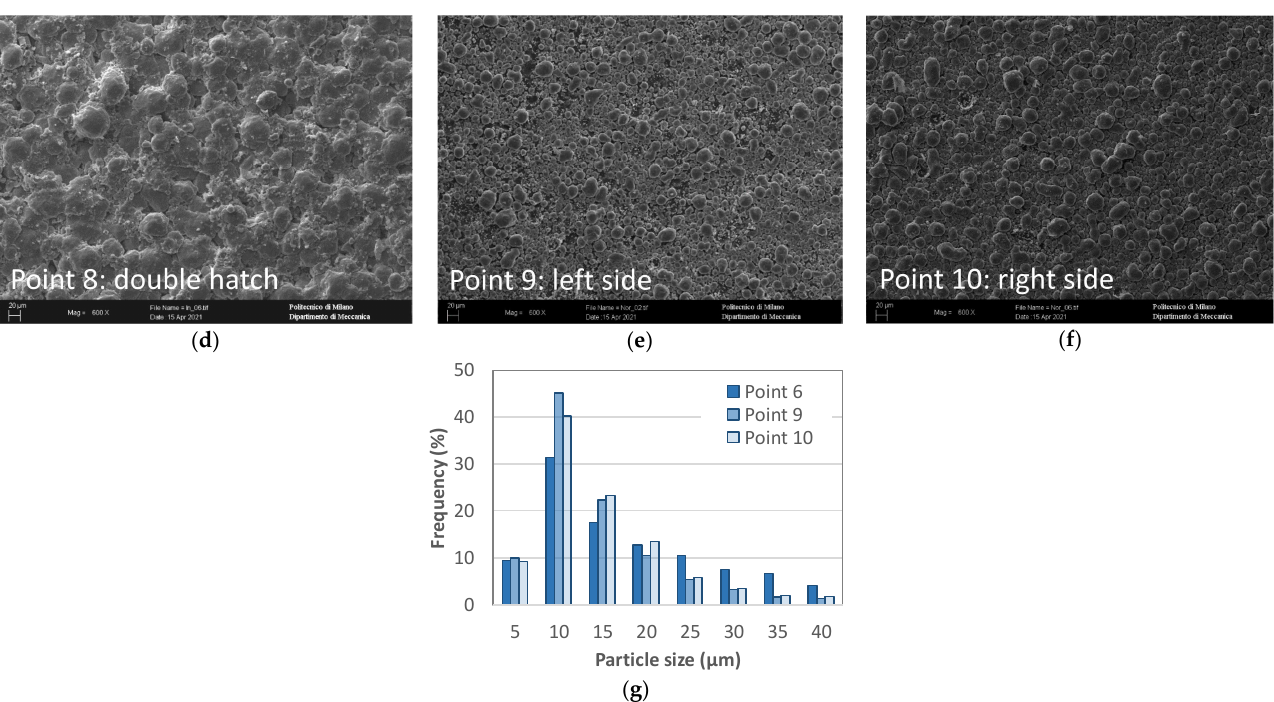
Figure 9. Specimen S2 , analysis of the coverage: ( a ) points location; ( b–f ) SEM-magnified images of the five points; ( g ) histogram of the particles’ sizes for points 6 (center of the hatch), 9 (left side), and 10 (right size).